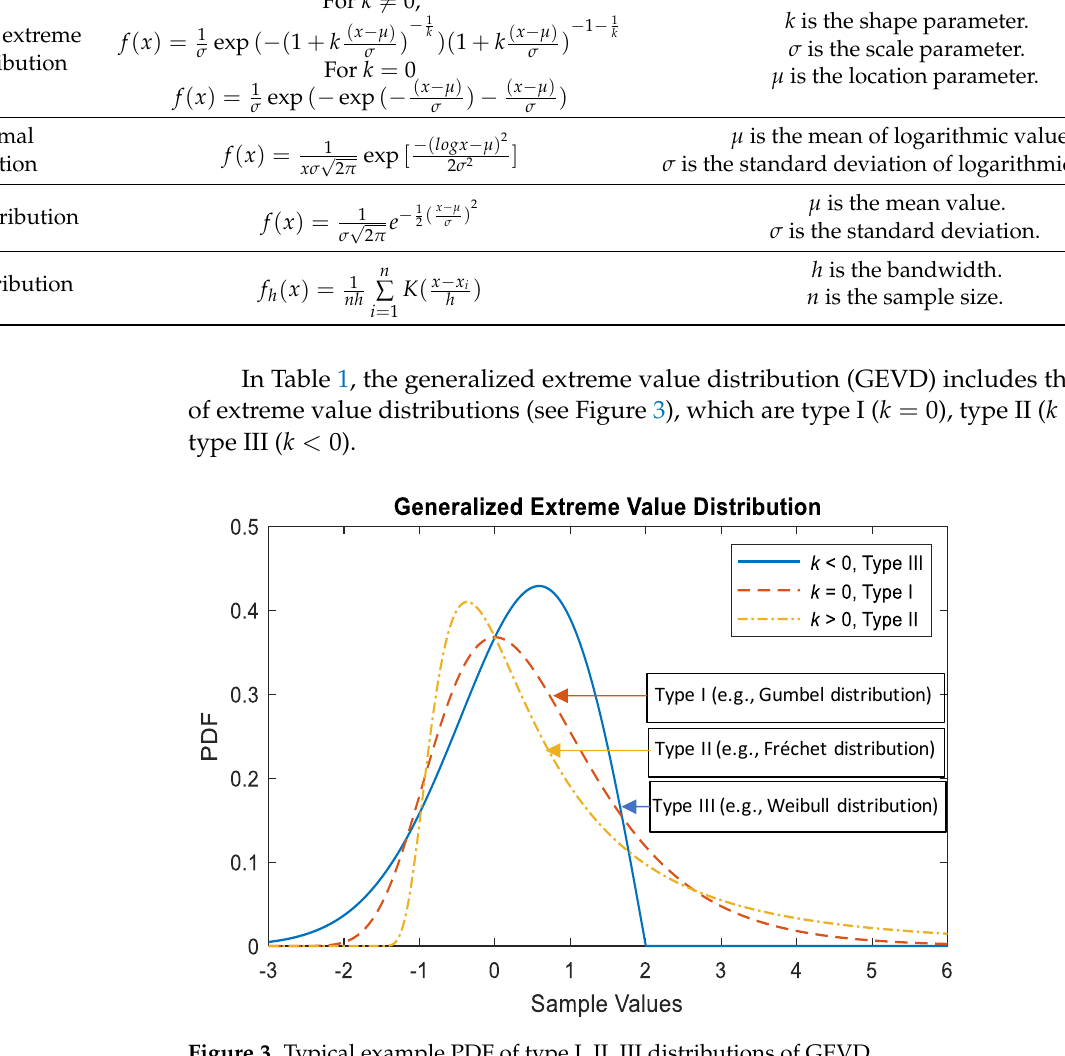
Table 1. The probability density function and their parameters.